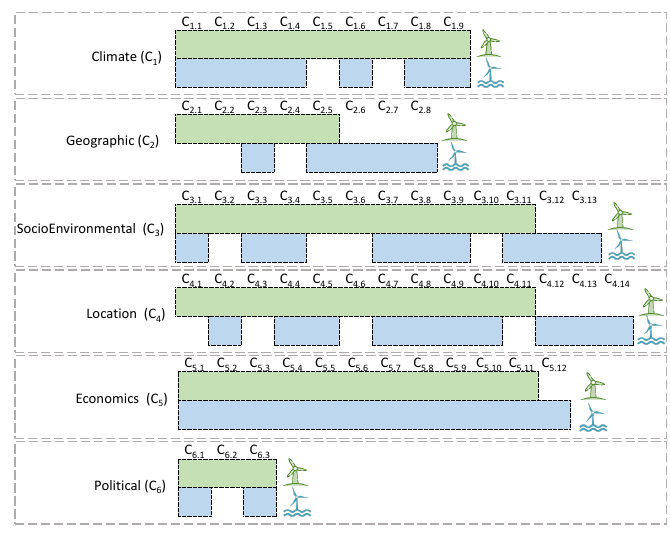
Figure 10. Categories and factors in onshore and offshore wind farm optimal location: global comparison.